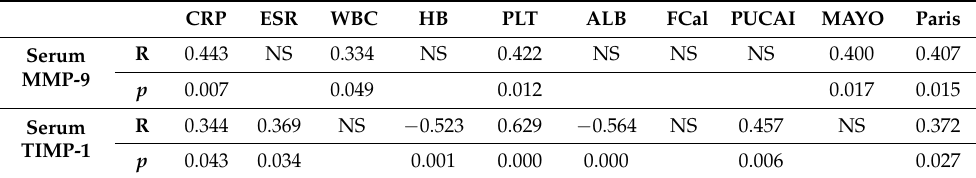
Table 6. Significant correlations (Spearman’s rank correlation analysis) of serum TIMP-1 and serum MMP-9 with the inflammatory markers, disease activity index and endoscopic